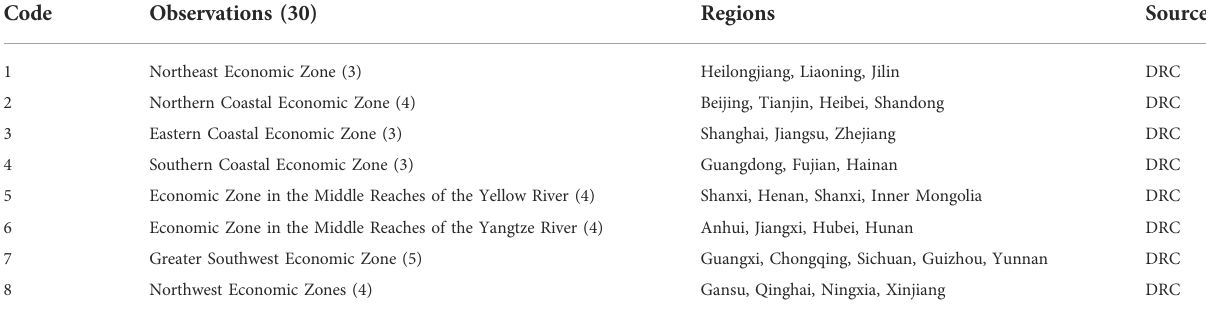
TABLE 3 Eight comprehensive economic zones in China under investigation (excluding Tibet).